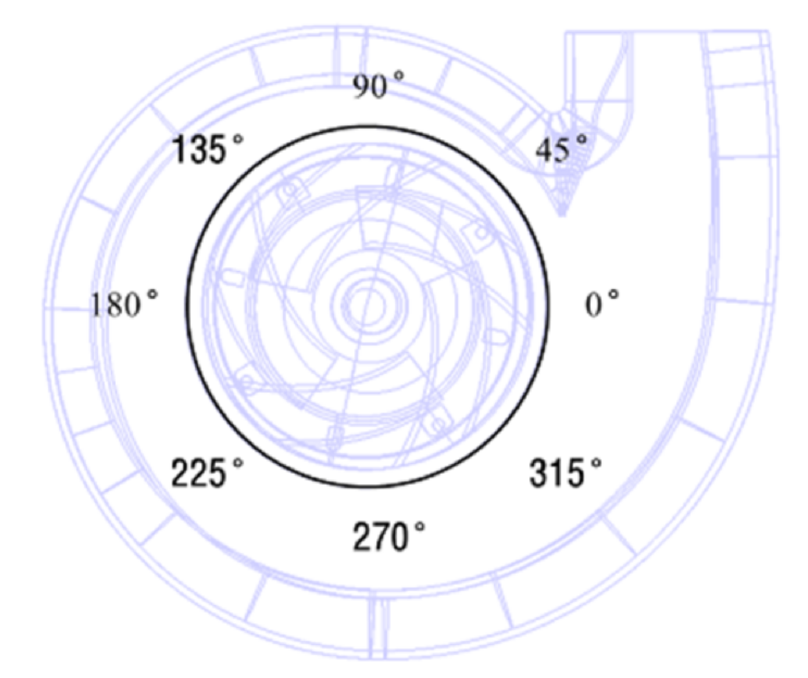
Figure 6. Wear map for different locations on an angular